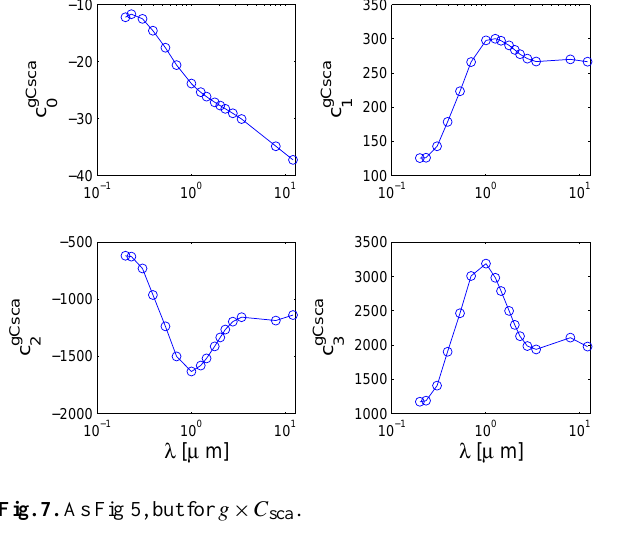
Fig. 7. As Fig 5, but for g × C sca .